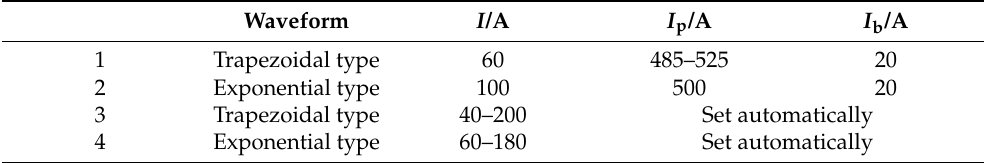
Table 1. The welding parameters used in this article.